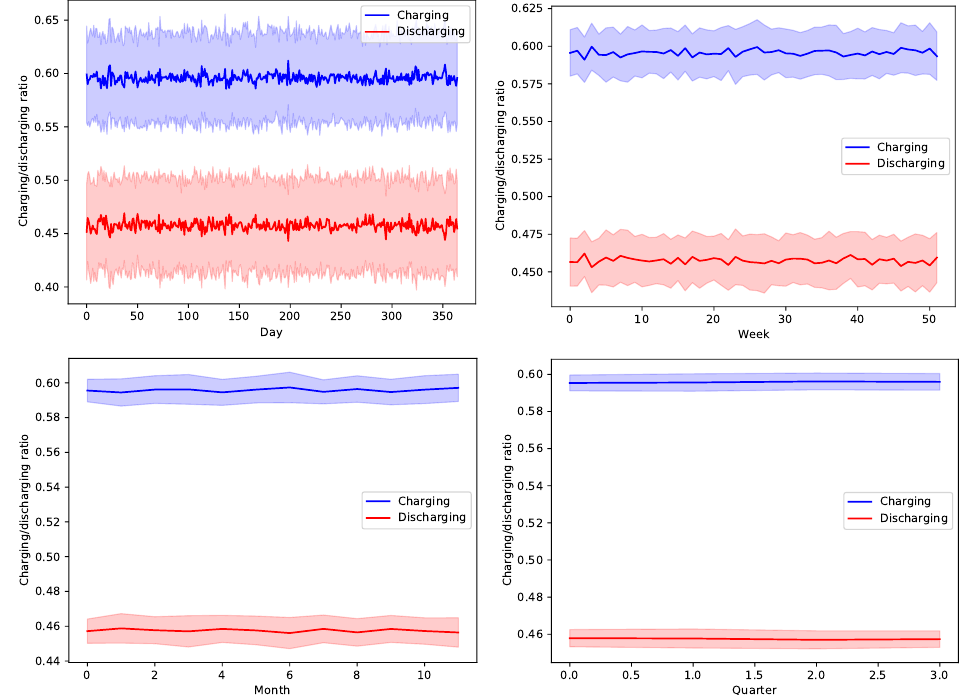
Figure 16. The average temporal charging and discharging ratios of EVs according to the greedy policy with a global certainty level U 75